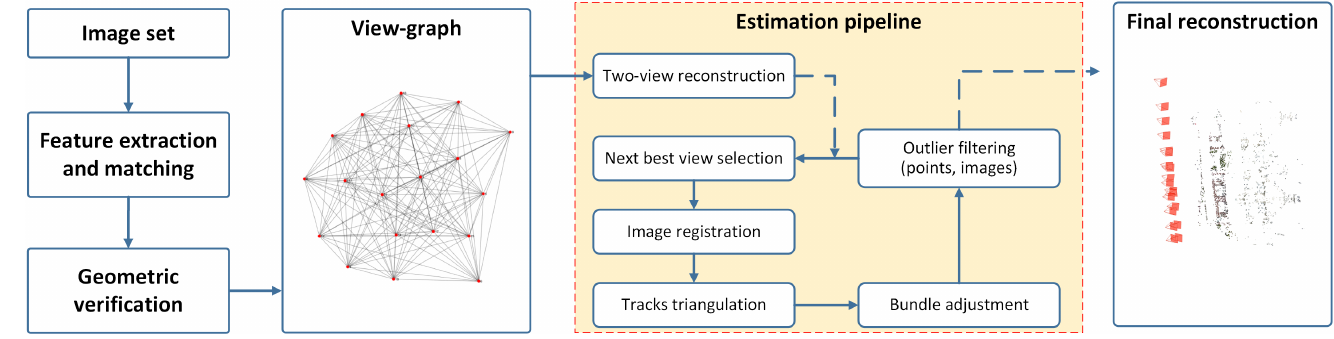
Figure 1. Workflow of COLMAP